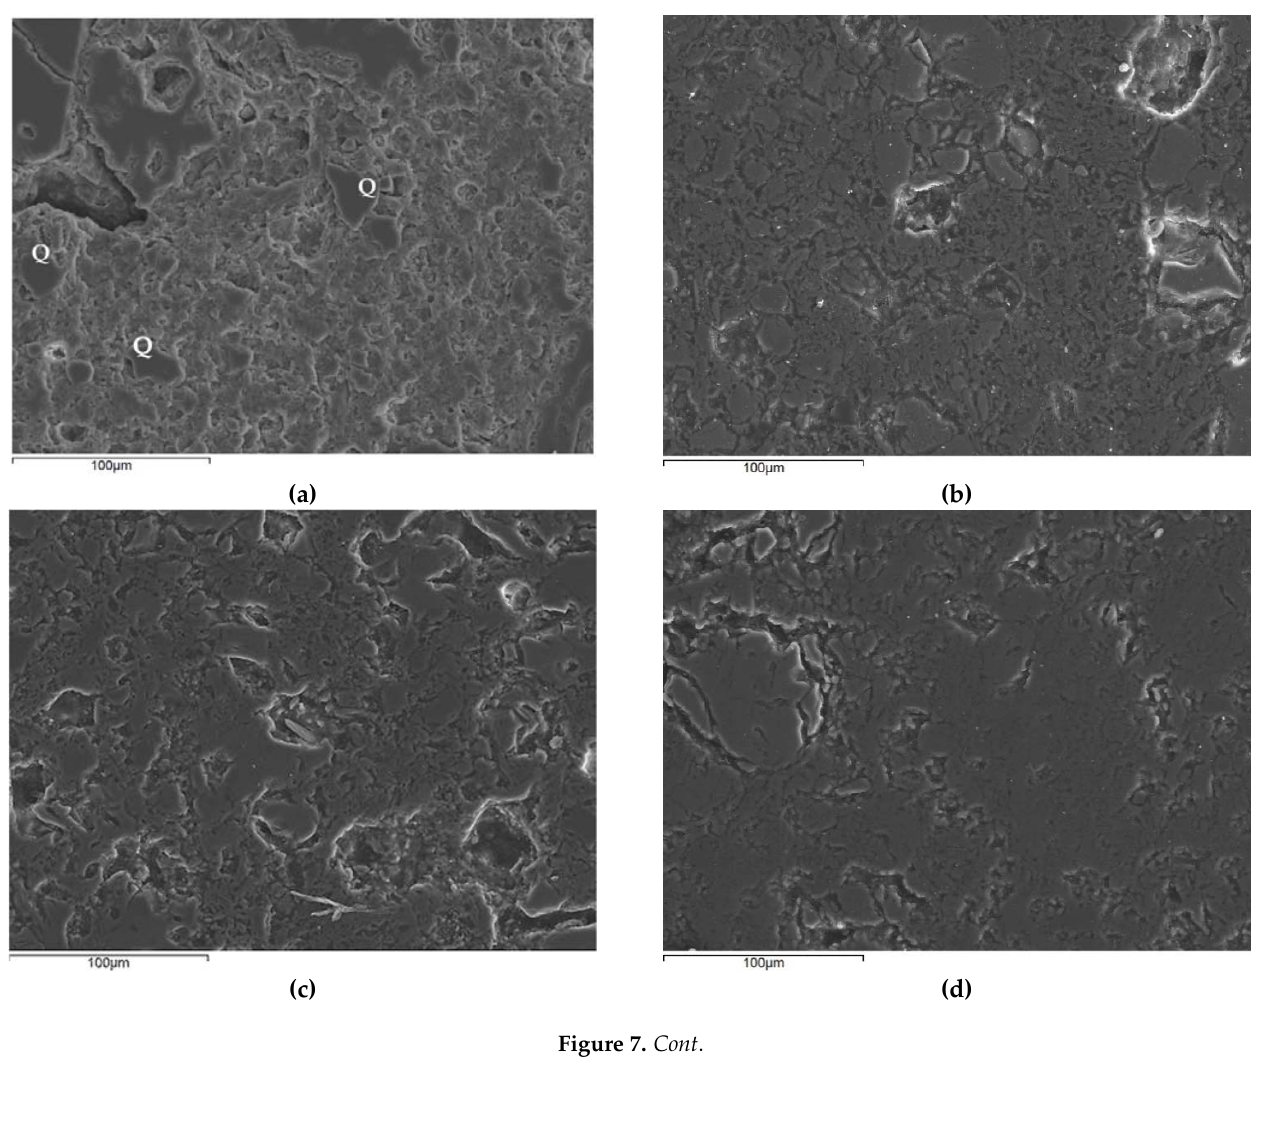
Figure 6. Ceramics’ hue variation in relation to CSM content. Transition from ochre-white to red- dish color with increase in CSM.